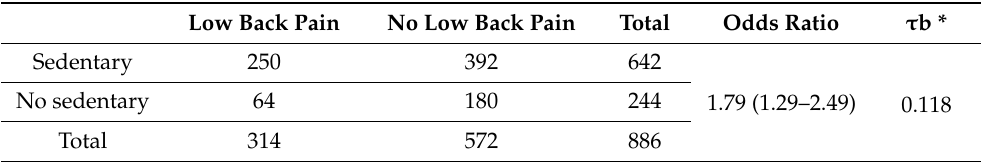
Table A2. Odds ratio between sedentary behavior and low back pain.